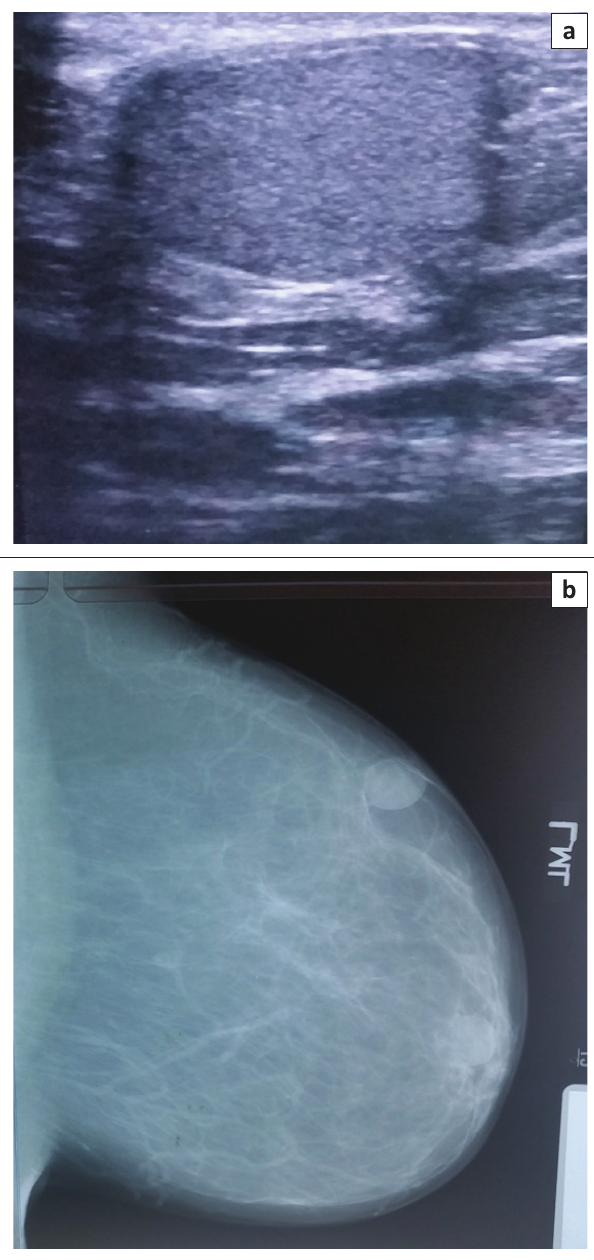
FIGURE 2: A palpable left breast lump in a 48-year-old woman. She had a breast trauma 3 years prior to presentation: (a) Ultrasound of the left breast showed a well-defined hyperechoic mass and (b) left medio-lateral oblique mammogram showing a mass with a calcified (egg shell) rim. At the patient’s request, she had a biopsy, which confirmed an oil cyst (from post-traumatic fat necrosis).